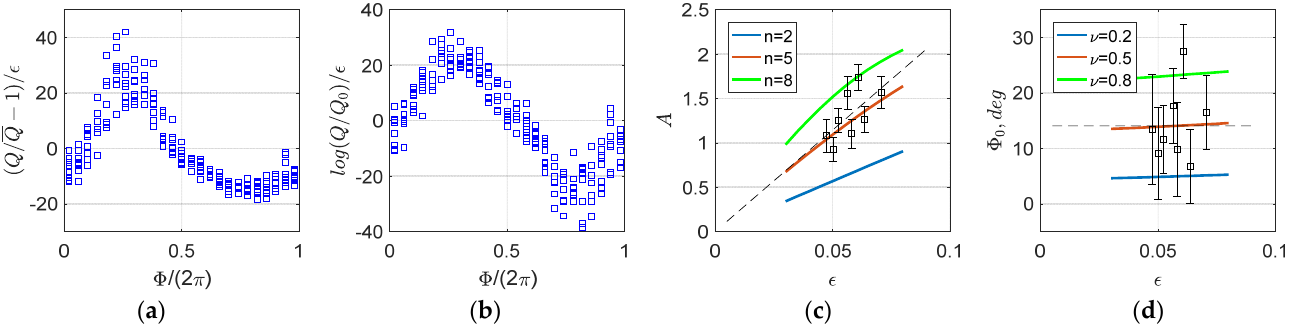
Figure 5. To data analysis: collapsing all the data using ( a ) linear (2) and ( b ) nonlinear (1) representations; ( c ) amplitudes and ( d ) phase shifts in fitting the log ( Q / Q 0 ) using A sin ( Φ − Φ 0 ) according to (1) as a function of long-wave steepness ε for all recordings. Black dashed lines show least-square estimates (3). Colored solid lines show model calculations for mean data characteristics U = 14.8 m/s and α = 0.63.